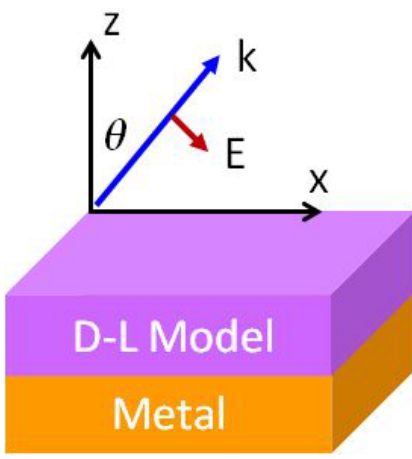
Figure 1: A schematic diagram of a bilayer structure. The permittivity of the primary (top) layer is described by Drude-Lorentz model while the secondary (bottom) layer is highly or totally reflective substrate, such as metal or PEC. The angle θ represents the direction of thermal emission or absorption.